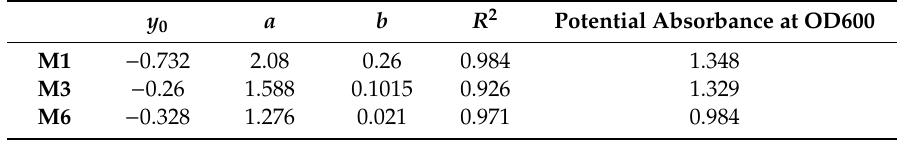
Table 2. Regression model for growth of L. pentosus (exponential rise to maximum, single, 3 parameter), run by Sigmaplot Version 14. The equation described is Equation (2) where y 0 , a , and b are constants and t is the cultured time.